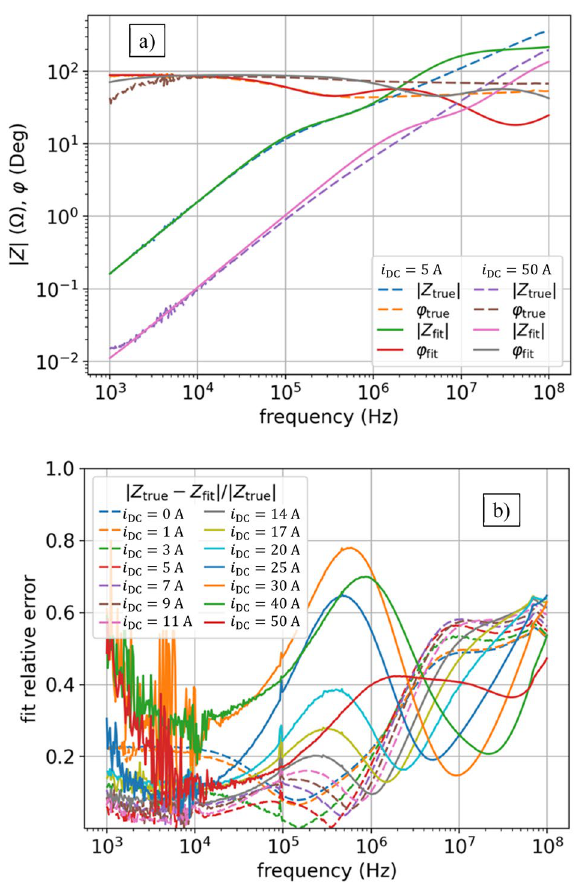
Figure 5. NLS with Langevin constraint results of impedance Z ( f , i DC ) fitting for model (6): ( a ) fit versus true values of | Z | (cid:31) f , i DC (cid:30) and ϕ( f , i DC ) for two currents: i DC = 5 A, i DC = 50 A; ( b ) relative error as per (4) for all currents. Enforcing monotonic inductances and constant resistances make optimization extremally hard. Best result after many trials for NLS with Langevin constraint gives unacceptable fitting